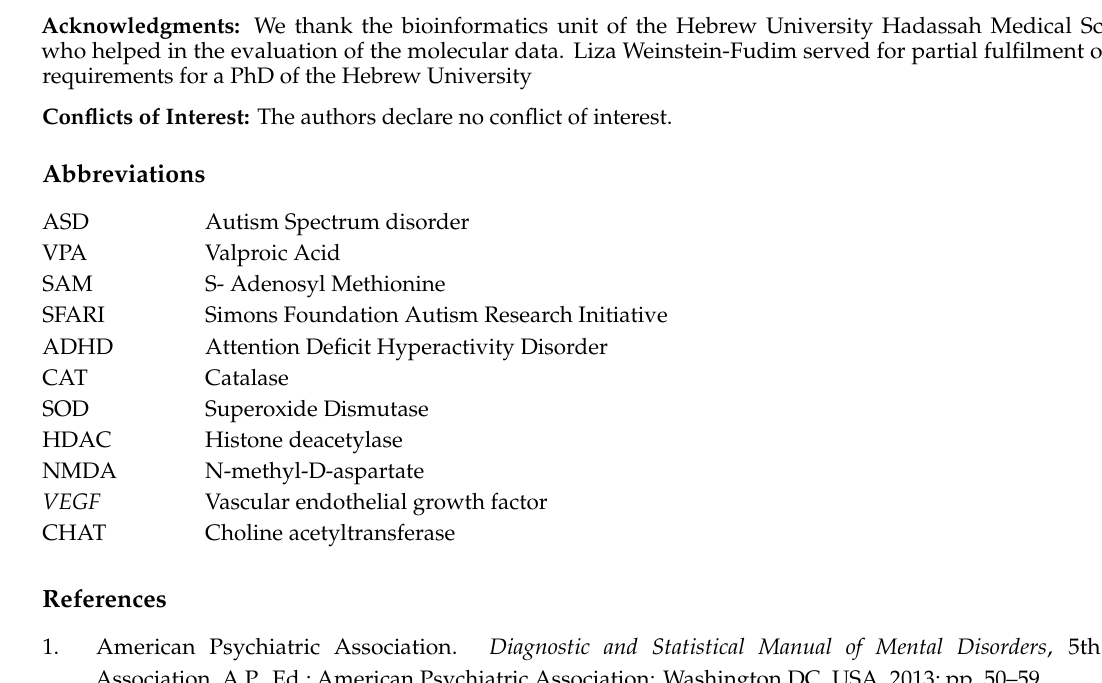
Figure S1: KEGG pathway analysis in females exposed to VPA. The distribution of di ff erentially expressed genes in prefrontal cortex of females exposed to VPA compared with controls in (A) Huntington’s disease pathway and (B) Alzheimer’s disease pathway. Significantly, deregulated genes are marked with red star, detected using DAVID / KEGG enrichment analysis of the Nanostring